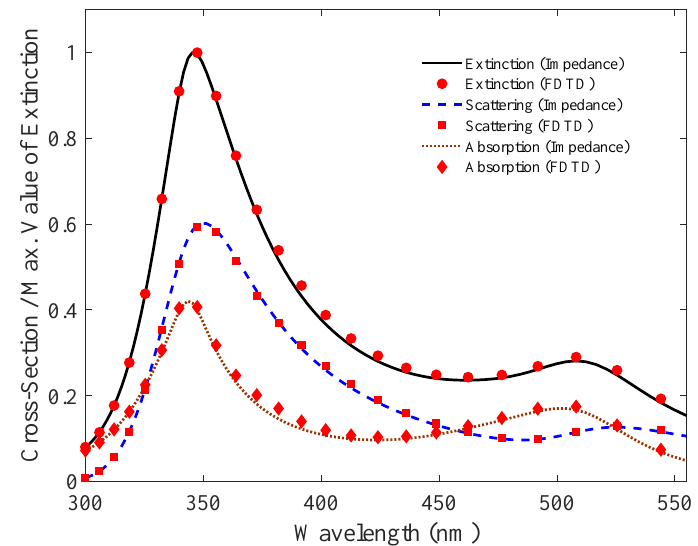
Figure 7. TE mode: Comparison of Q ext , Q sca and Q abs simulation for a 40 nm radius cylindrical nanowire using our proposed impedance model with the full-wave field solver. The values are normalized to unity for the extinction cross-sectional area efficiencies, with scattering and absorption plot scaled accordingly. The simulation result show negligible difference between the two